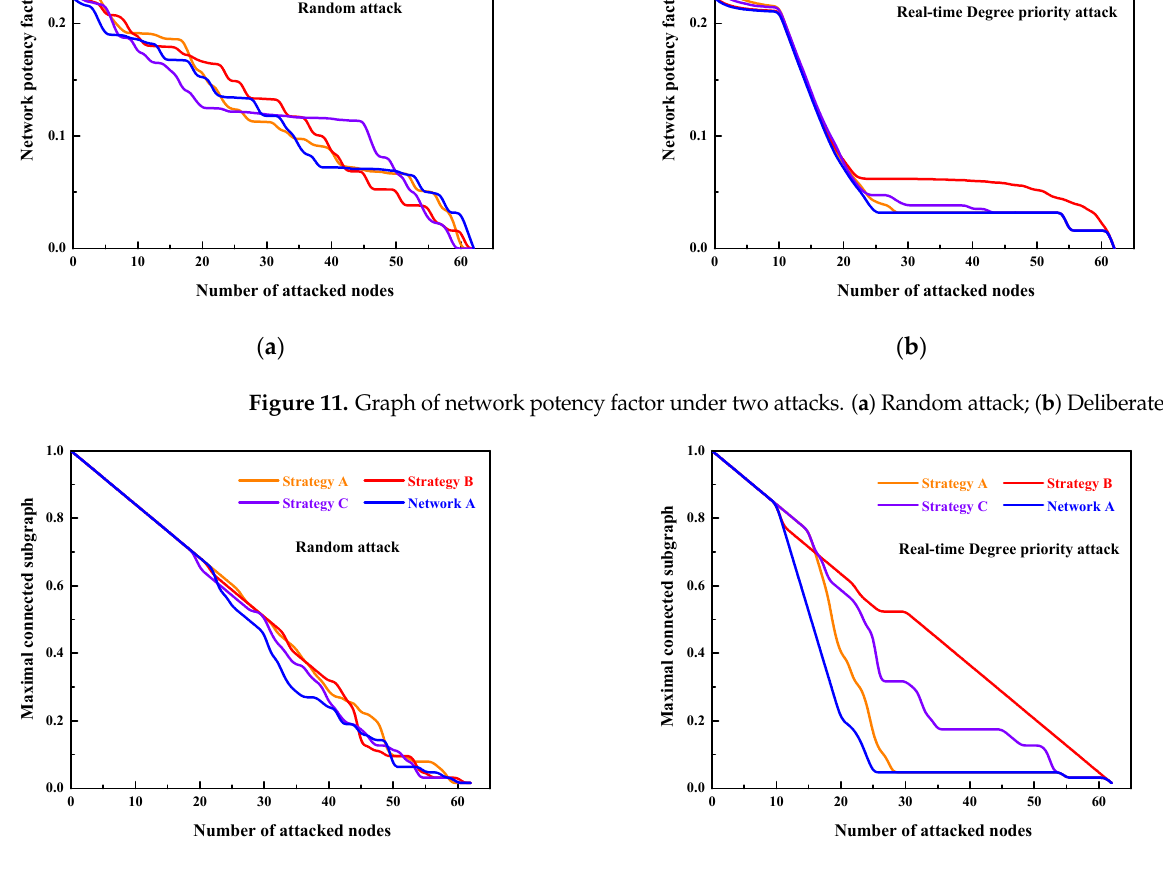
Figure 12. Graph of maximal connected subgraph under two attacks. ( a ) Random attack; ( b ) Delib- erate attack.